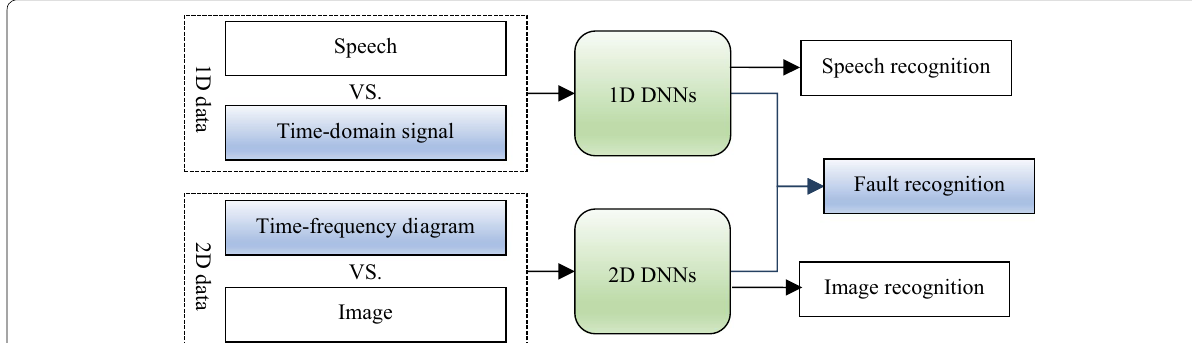
Figure 11 Similarity between fault diagnosis and other pattern recognition issues